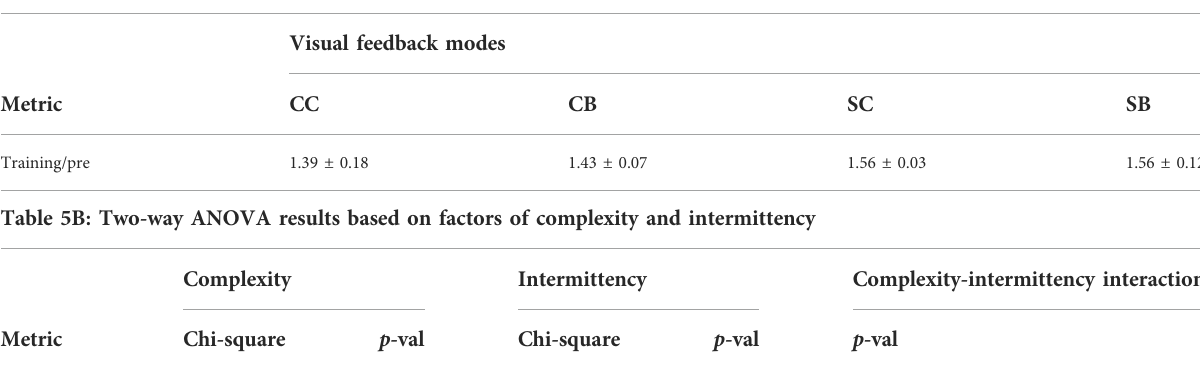
TABLE5Electrodermalactivityduring training witheachfeedbackmode. Resultspresentedasthe meanskinconductanceduring training divided by pre-training (train/pre). Table 5A: Mean EDA results (microsiemens)